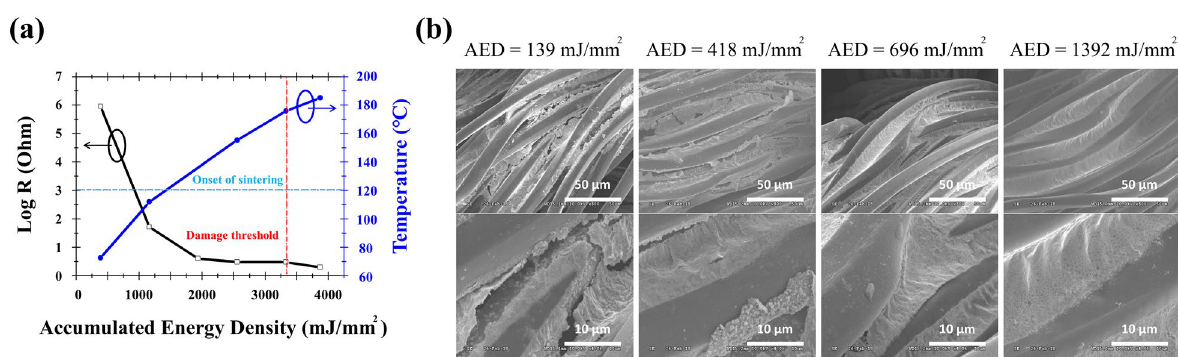
Figure 3. ( a ) The length resistance and real-time temperature as a function of the accumulated energy density (AED). ( b ) SEM images for fabrics treated with various AED. The fabric surface finish turns smoother and void- free when the AED is increased beyond 1392 mJ/mm 2 fidelity. Figure 1c shows the SEM image of the cross-section of the as-metallized fabric. It is clear in evidence that metallization occurred effectively not only on the surface but between fibers.